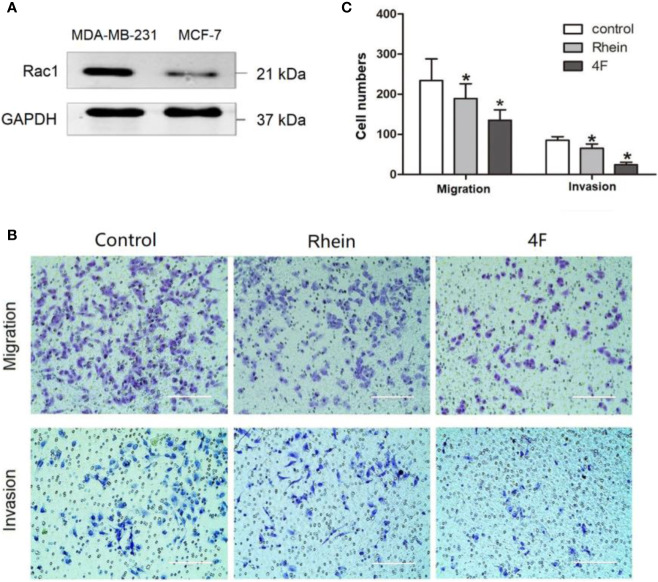
Transwell assay to test MDA-MB-231 cell migration and invasion ability. The control group correspond to cells growing without any drug. (A) Rac1 protein expression in MDA-MB-231 and MCF-7 cells. (B) Transwell assay of MDA-MB-231 cells (scale bar: 200 μm). (C) Numbers migrated and invaded MDA-MB-231 cells. Data are shown as means ± SD (n = 5). One-way analysis of variance (ANOVA) was used for statistical analysis. *P < 0.05, comparison of Rhein group or derivative 4F group and control group on MDA-MB-231 cells.